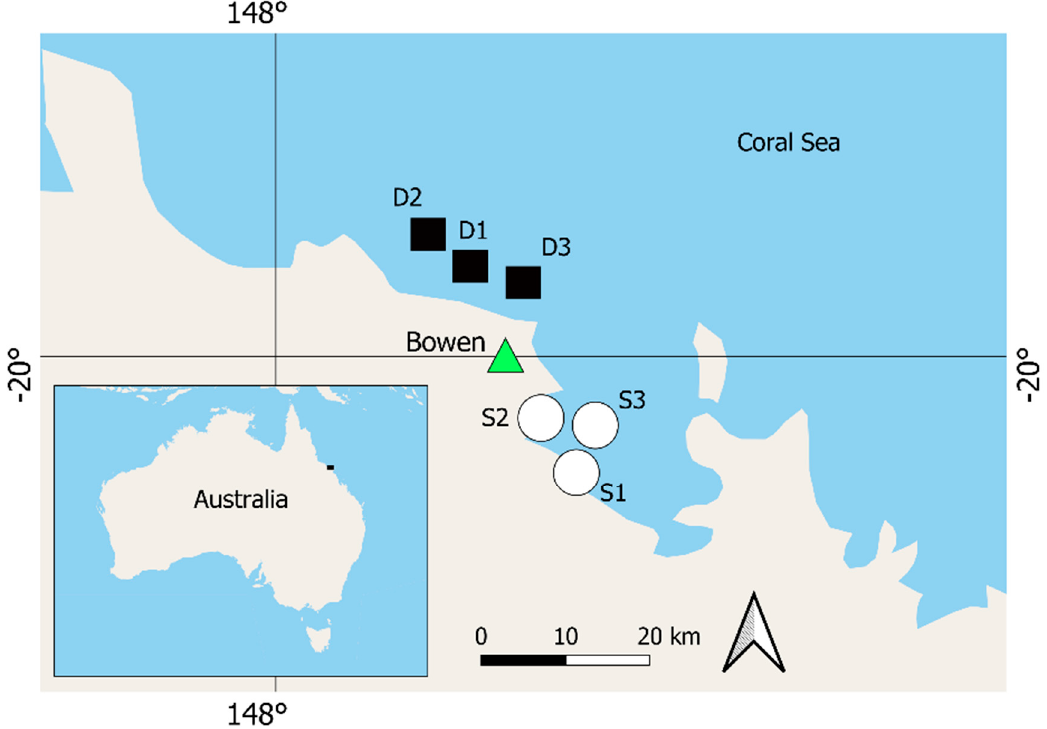
Figure 1. Map showing locations for each trawl site at deep (D; black squares) and shallow (S; white circles) seagrass meadows within The Great Barrier Reef World Heritage Area, Queensland, Australia.